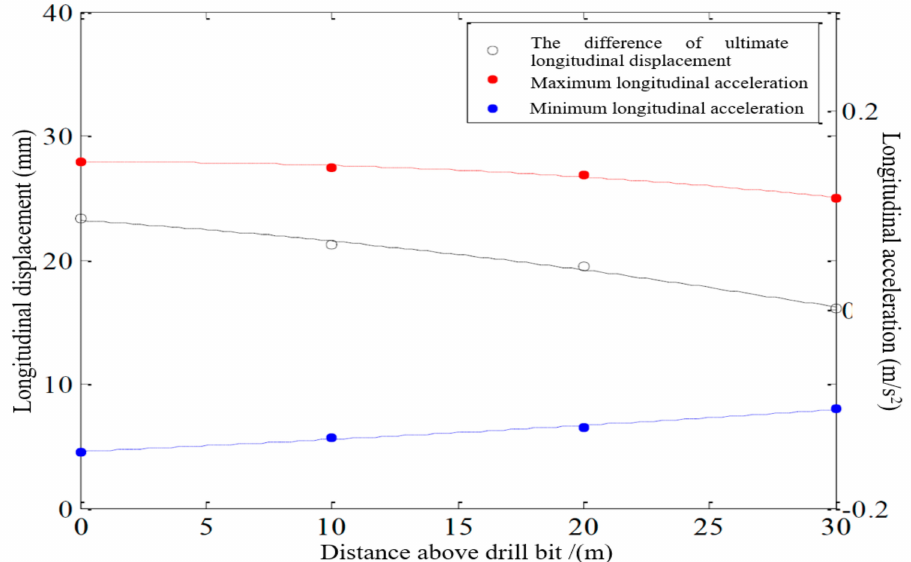
Figure 15. The variation of longitudinal motion amplitude and ultimate acceleration of drill string with spring